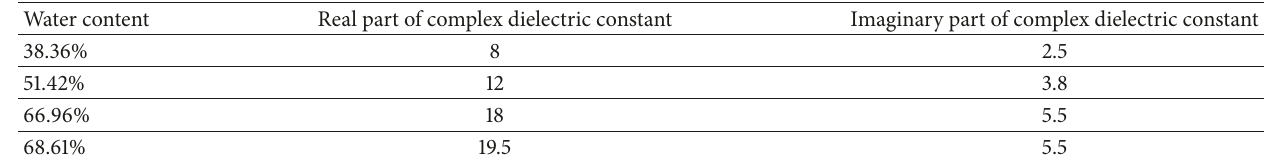
Figure 8: Near scattering field of ground surface with different water content of leaves. (a) Water content is 38.36%. (b) Water content is 51.42%. (c) Water content is 66.96%. (d) Water content is 68.61%. Table 1: Relationship of complex dielectric constant with water content for corn